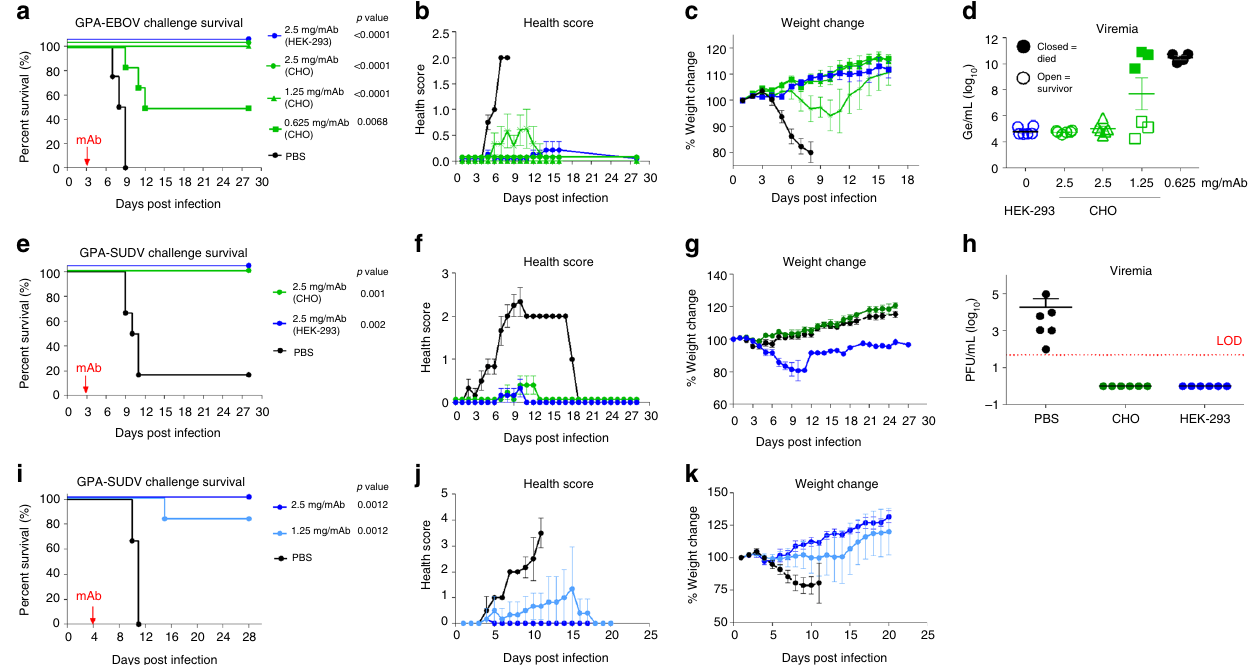
Fig. 1 Ef fi cacy of the PE cocktail in guinea pigs against EBOV and SUDV. a Survival, b health score, and c weight change in animals challenged with guinea pig-adapted EBOV (GPA-EBOV) and d day 7 viremia data, determined by RT-qPCR. Control group ( n = 4) was given PBS while treatment groups ( n = 6) received antibodies on day 3 postinfection. e Survival, f health score, g weight change, and h viremia by plaque assay (individual animals and mean ± SD) from animals ( n = 6) challenged with guinea pig-adapted SUDV (GPA-SUDV) and treated 3 days postinfection or control animals given PBS ( n = 6), LOD limit of detection. i Survival, j health score, and k weight change in animals ( n = 6) treated 4 days postinfection with guinea pig-adapted SUDV (GPA- SUDV) or control animals ( n = 6) given PBS. CHO (green) or 293T (blue) represent the cell line in which antibodies were produced. Error bars represent the mean value of the six animals in each group ± standard deviation (SD). Statistical analysis of survival was performed by log-rank